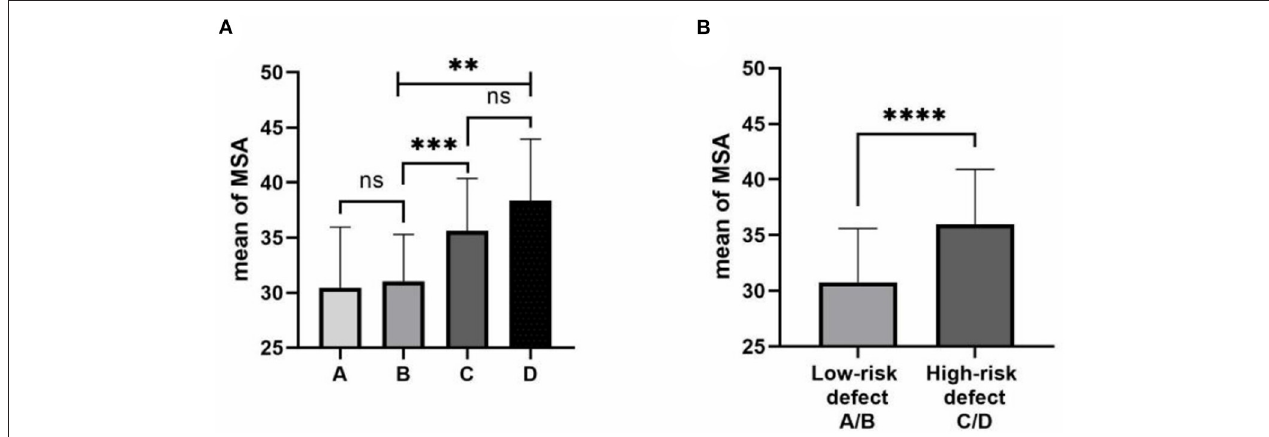
FIGURE 4 | Correlation of MSA and degree of the diaphragmatic defect. (A) MSA values by CDHSG defect stage. The one-way ANOVA was used for group comparison. (B) MSA values by low and high-risk defects. The two-tailed test was used for group comparison. ns: not significant, ** p < 0.01, *** p < 0.001, **** p < 0.0001.